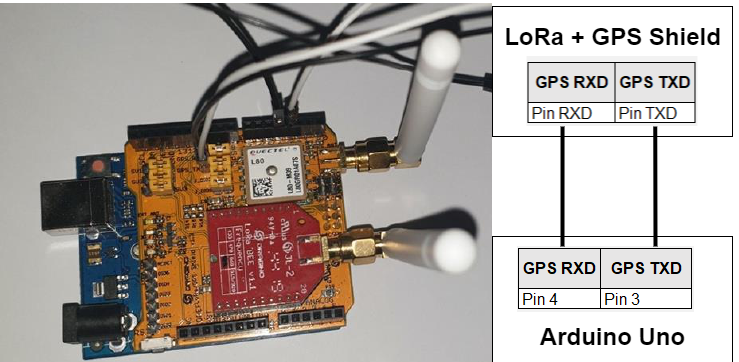
Figure 7. LoRa Endnode Hardware and Connection Diagram.